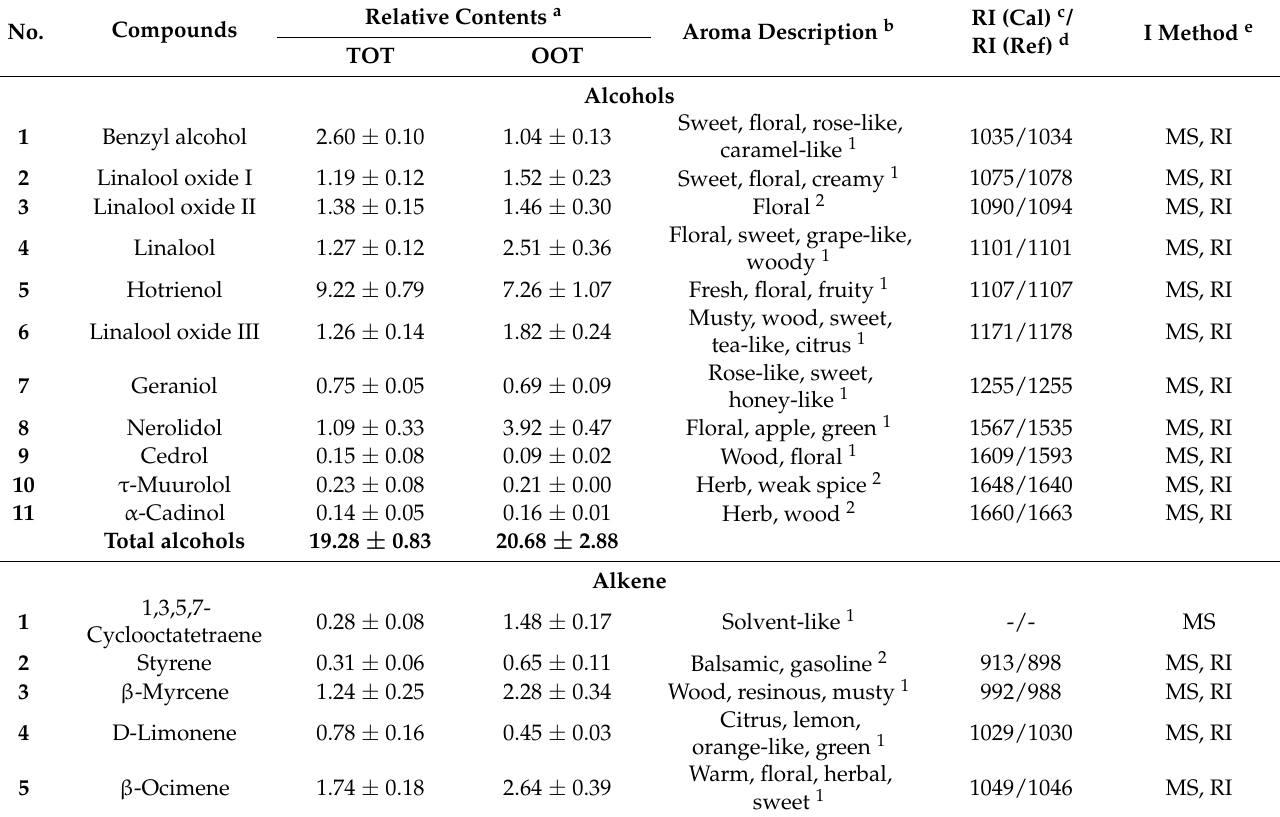
Table 2. Summary of volatile compounds in TOT and